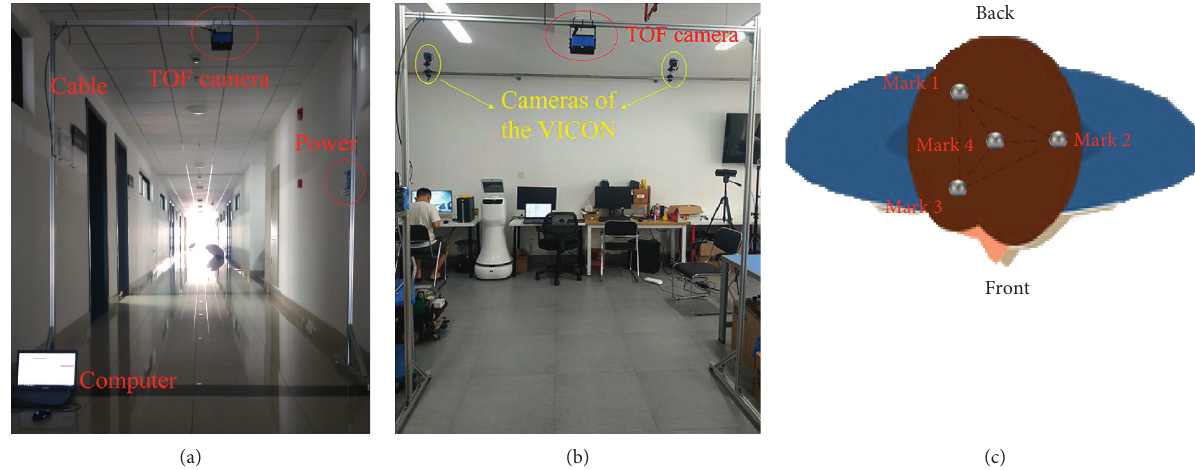
Figure 5: Experimental setup. (a) Site: campus corridor. (b) Site: research room. (c) Placement layout of the lightweight reflective balls.